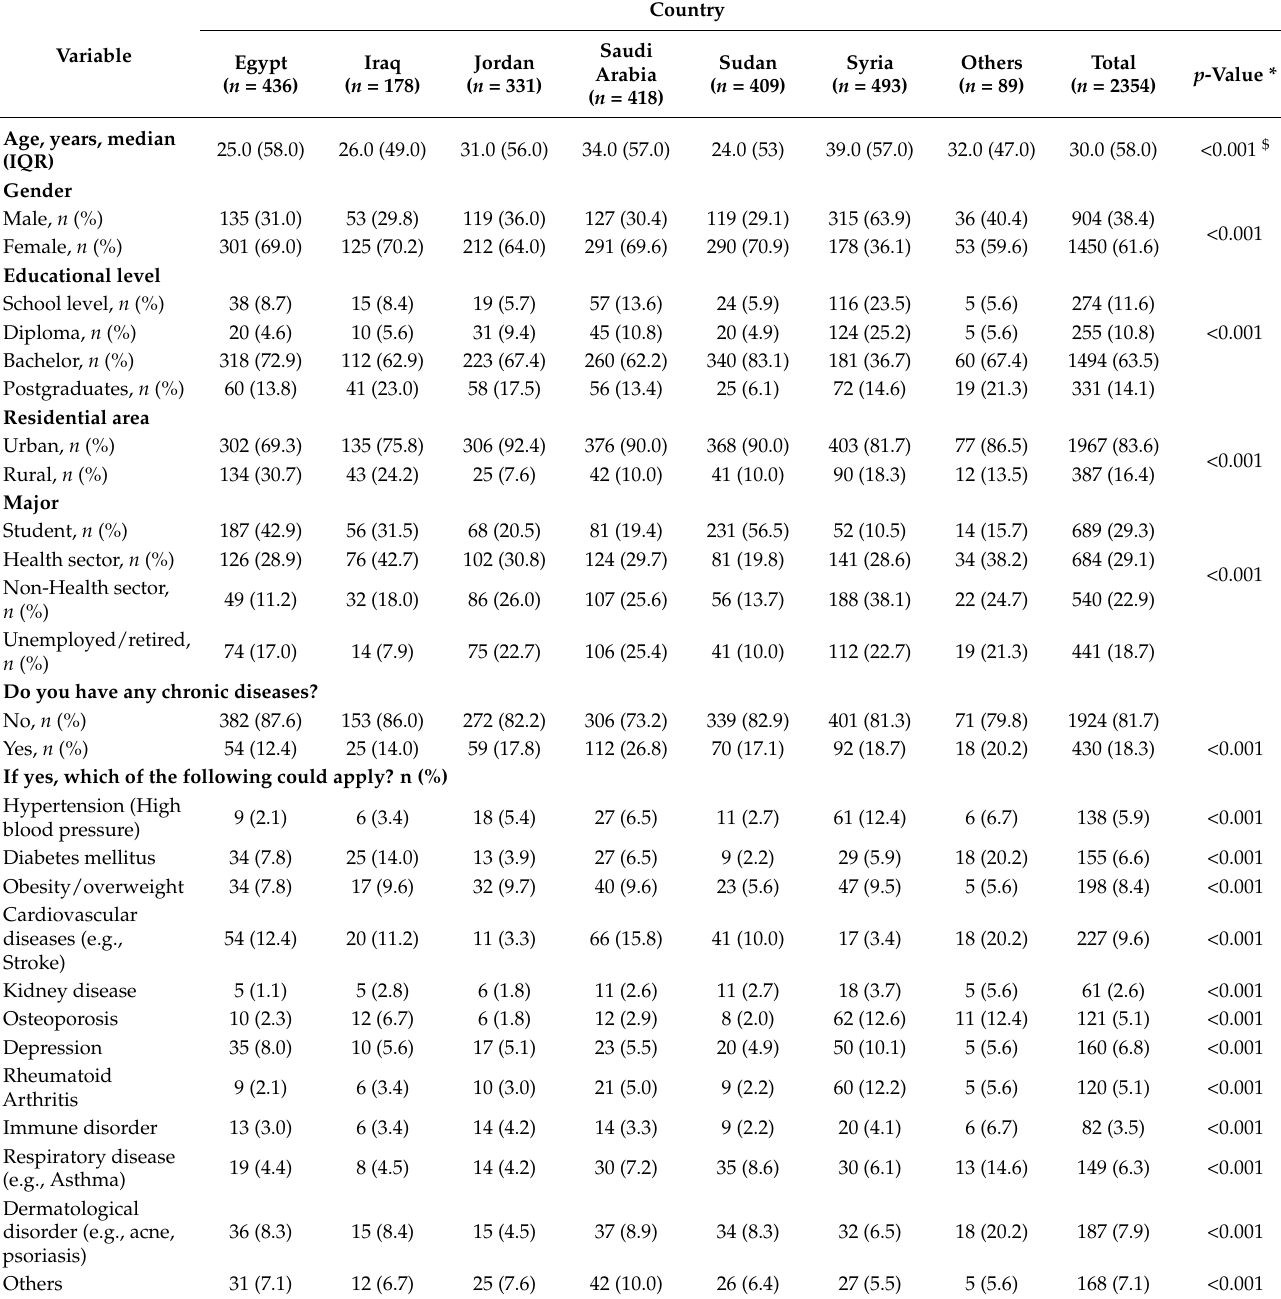
Table 1. Sociodemographic characteristics of study participants ( n =